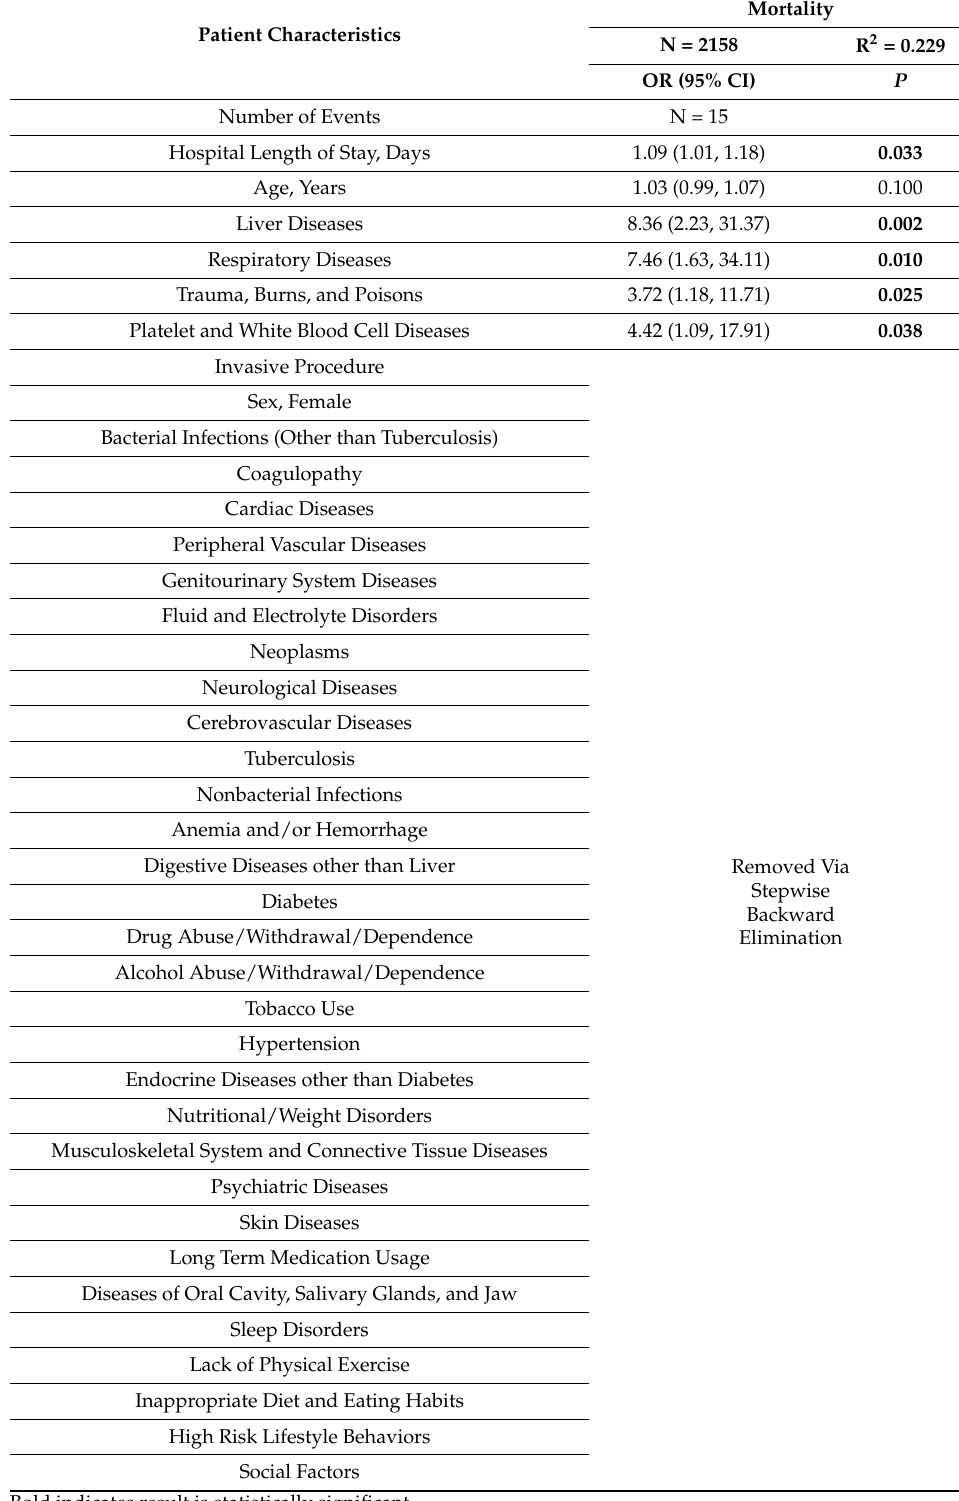
Table 4. Backward multivariable logistic regression analysis to evaluate the associations between mortality and different risk factors in patients emergently admitted with a primary diagnosis of blunt chest wall injury (NIS 2004–2014). Mortality is the dependent